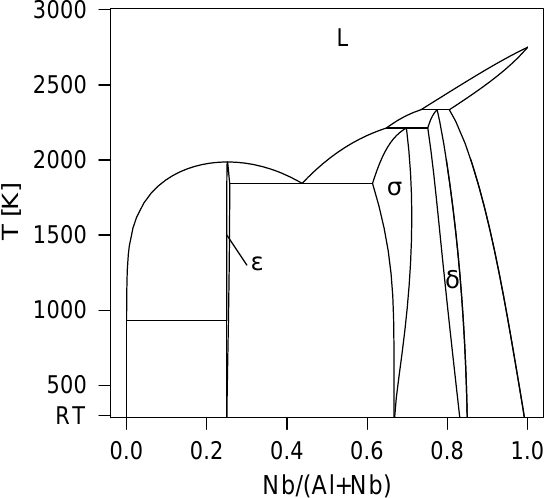
Figure 1. CALPHAD-based phase diagram of the binary Al–Nb system from room temperature (RT) up to 3000 K showing the ε -Al 3 Nb, σ -AlNb 2 , and δ -AlNb 3 phase.